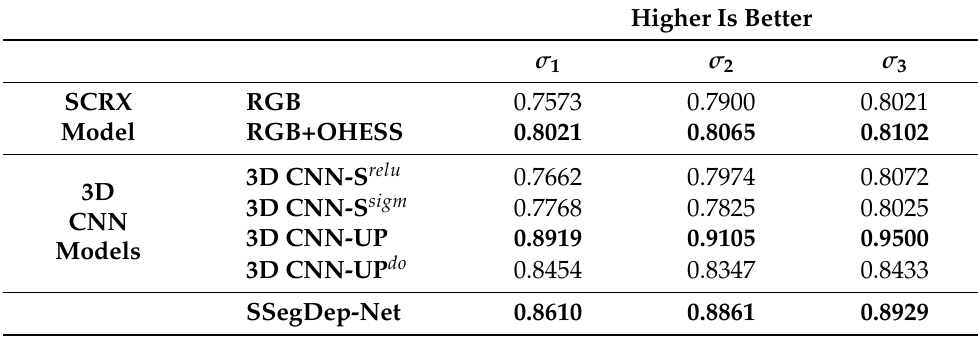
Table 4. Quantitative results using the threshold metric σ (see the Appendix A. 3D CNN-S relu uses ReLU in the last layer, 3D CNN-S sigm uses sigmoid in the last layer, and 3D CNN-UP do adds dropout).